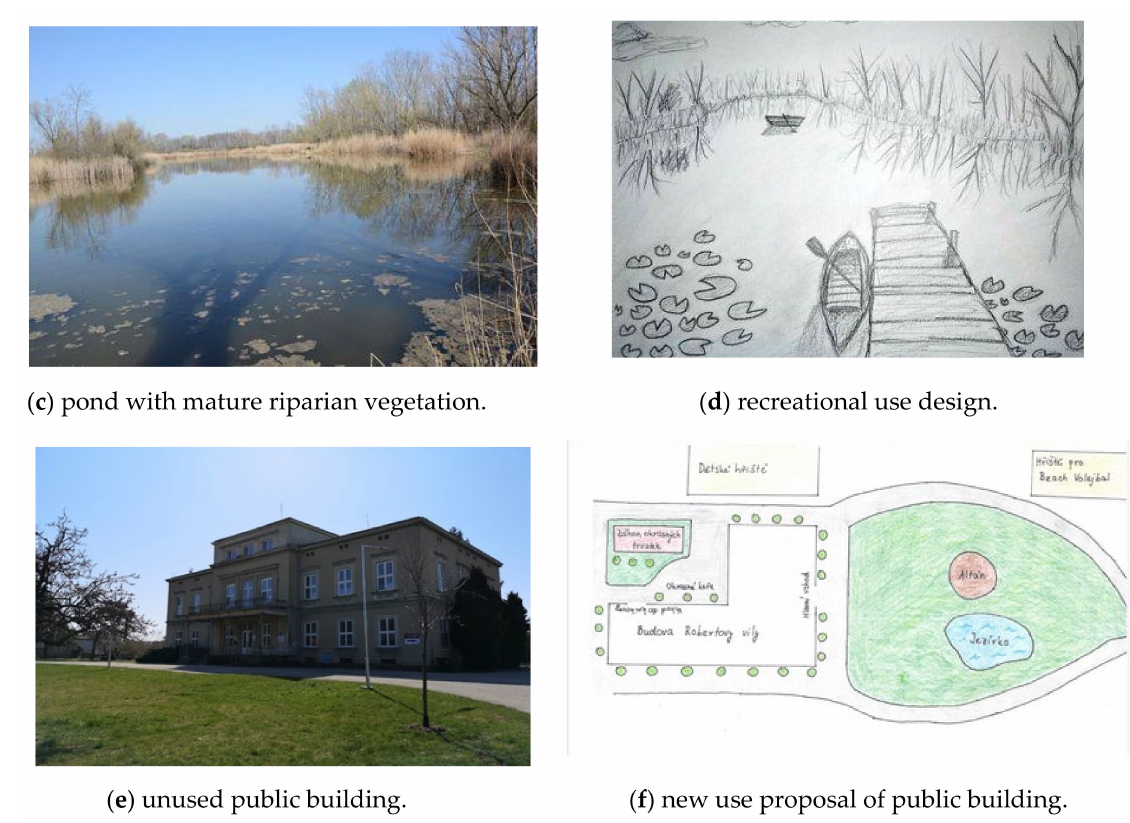
Figure 9. ( a – f ) Example of submitted proposals for dealing with the problematic areas. Source: photographed and elaborated by pupils of the participating school (a grammar school in Židlochovice).